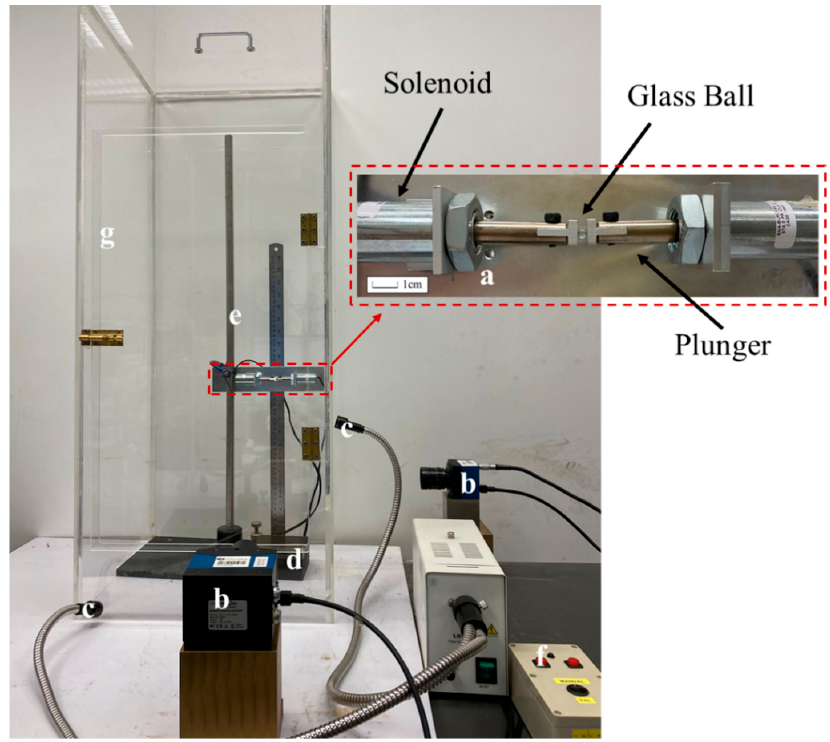
Figure 5. Image of the impact experimental setup inside a Perspex chamber showing its major components: ( a ) solenoids; ( b ) high-speed cameras; ( c ) focused LEDs; ( d ) base plate; ( e ) cantilever pole to adjust height; ( f ) trigger switch; ( g ) Perspex chamber.